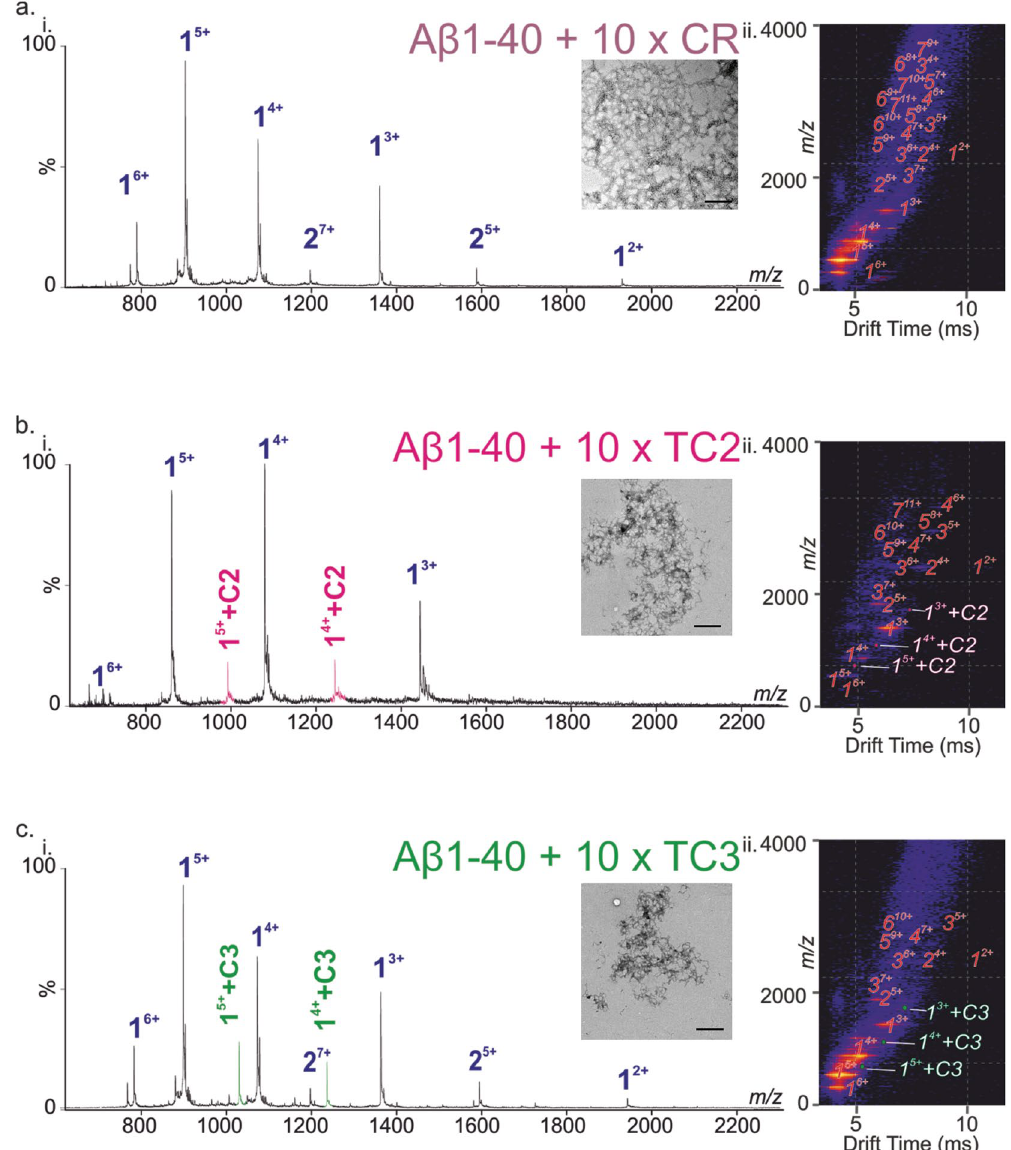
Figure 3. Inhibition screening of the Aβ 1-40 amyloid assembly by CR, TC2 and TC3. The ESI mass spectra of the Aβ 1-40 peptide in the presence of a tenfold molar excess of ( a-i ) CR, ( b-i ) TC2 and ( c-i ) TC3. The oligomer order is denoted above the mass spectral peak along with the positive-charge state of the ion as superscript. ESI IM-MS Driftscope plots of the Aβ 1-40 peptide oligomers in the presence of a tenfold molar excess of ( a-ii ) CR, ( b-ii ) TC2 and ( c-ii ) TC3, showing monomer (1) through the heptamer (7) or hexamer (6) in the case of TC3. The respective TEM images of the samples after 48 h of incubation (water pH 5.8, quiescent, 25 °C) are shown in the insets. Scale bars 500